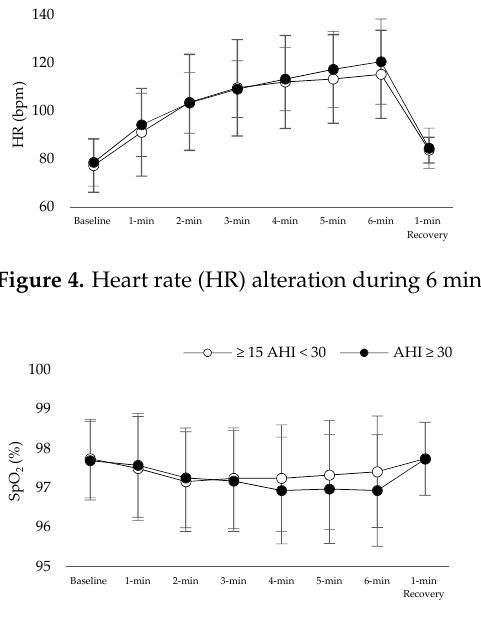
Figure 5. Oxygen saturation (SpO 2 ) alteration during 6 min walk test.